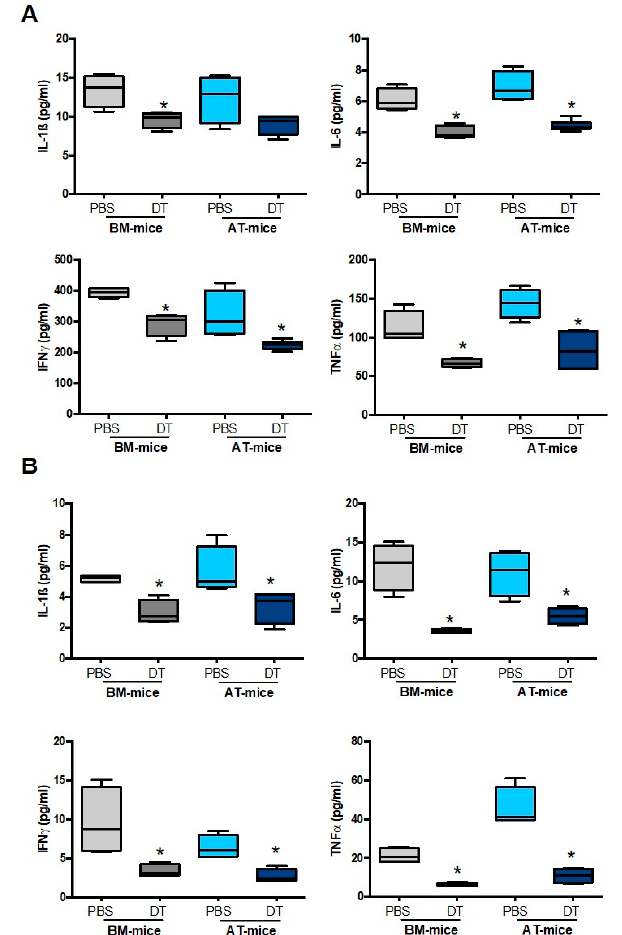
Figure 4. Depletion of adipose tissue-derived CD11c + macrophages lowers cardiac inflammation. IL-1 α , IL-6, IFN γ and TNF α levels in the heart ( A ) and the blood ( B ) of AT- and BM- chimeric mice treated with or without diphtheria toxin (DT), 7 days post- MI (n = 4–6). Comparisons between groups were performed using Dunn’s multiple comparisons test. * p < 0.05 in DT vs. PBS treated mice.